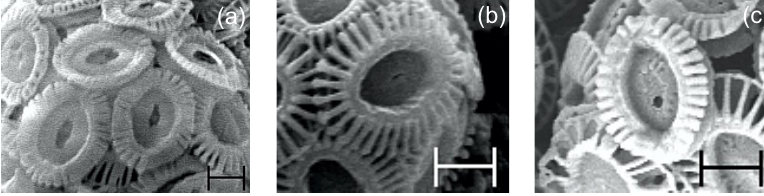
Figure 4. Examples of incomplete coccoliths of E. huxleyi RCC1710 (a) , RCC1252 (b) , and IAN01 (c) . Scale bar equal to 1µm.